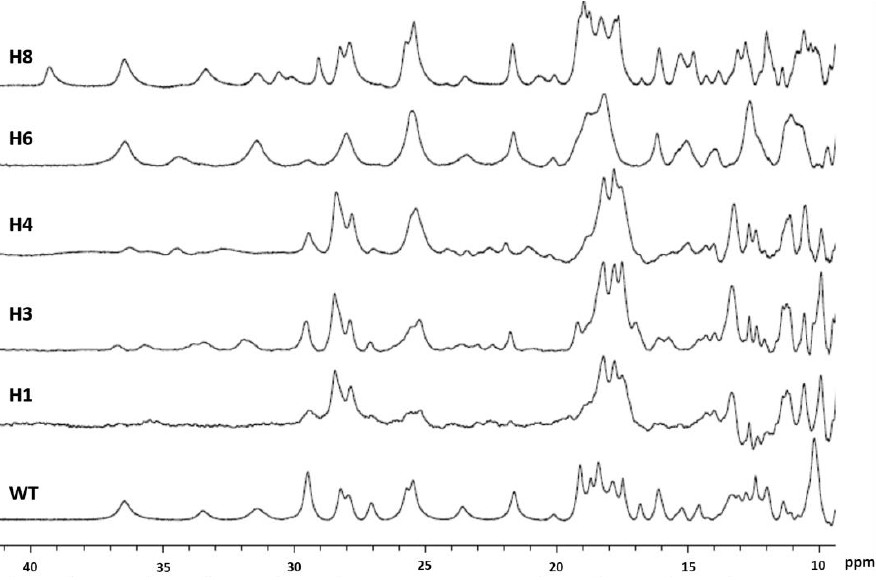
Figure 1. 1 H 1D-NMR spectra of native OmcA and mutants H1, H3, H4, H6, and H8 where the distal axial ligand of the hemes was mutated to a methionine.